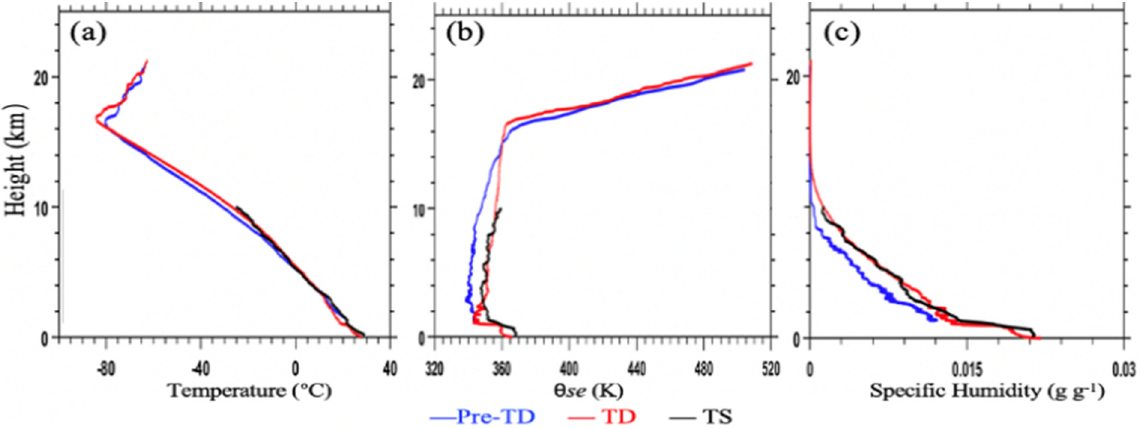
Figure 6. The profiles of ( a ) temperature, ( b ) pseudo-equivalent potential temperature ( θ se ), and ( c ) specific humidity at the three different evolutionary stages of Typhoon Sinlaku: ( a ) pre − TD, ( b ) TD, and ( c ) TS.